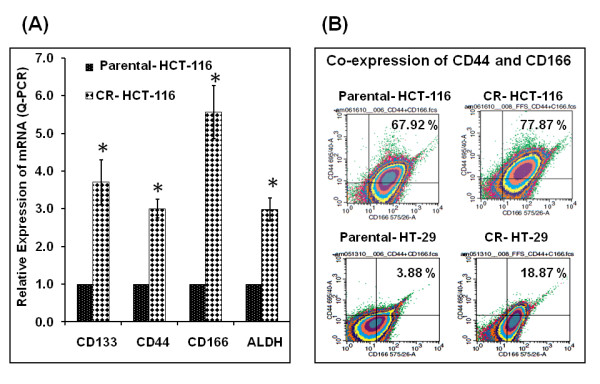
(A) Relative expression of various cancer stem cell markers in chemo-resistant (CR) HCT-116 cells as determined by RT-PCR; (B) Sorting of anti-CD44 and anti-CD166 antibodies-tagged untreated (control) and CR HCT-116 and CR- HT-29 cells by flow cytometry. Parental cells were maintained in DMEM, supplemented with 5% FBS and 1% antibiotic and antimycotic. The CR cells were continuously exposed to 50 μM 5-FU and 1.25 μM oxaliplatin.